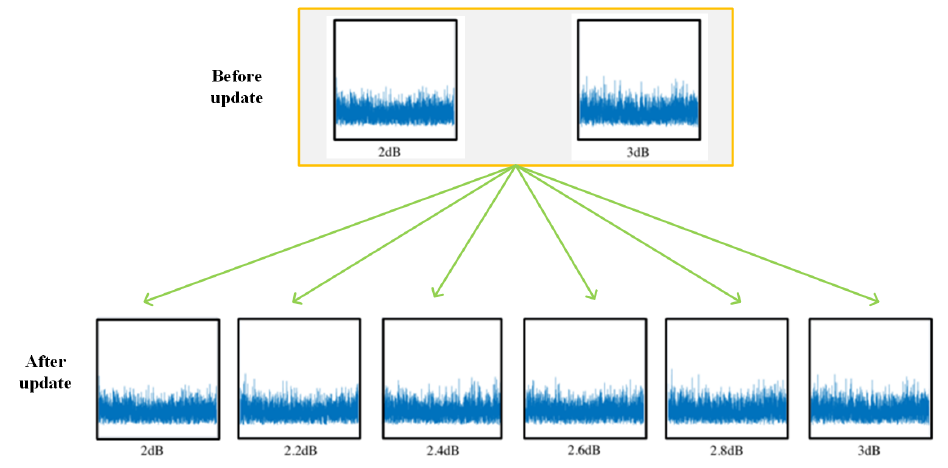
Figure 6. Comparison of datasets before and after update.